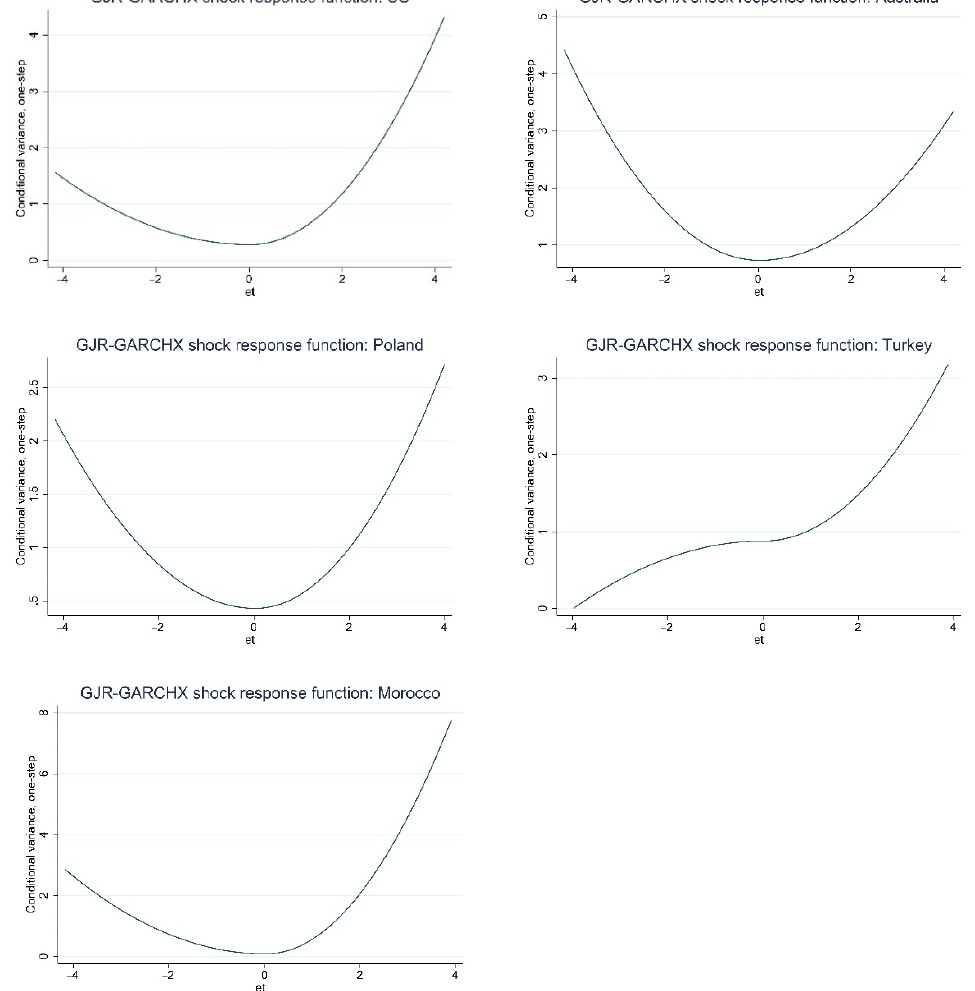
Figure 2. GJR-GARCHX shock response functions for the studied countries.